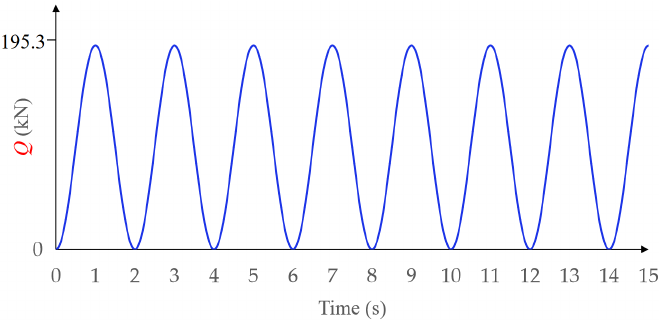
Figure 3. Finite element model of contact between roller and raceway.